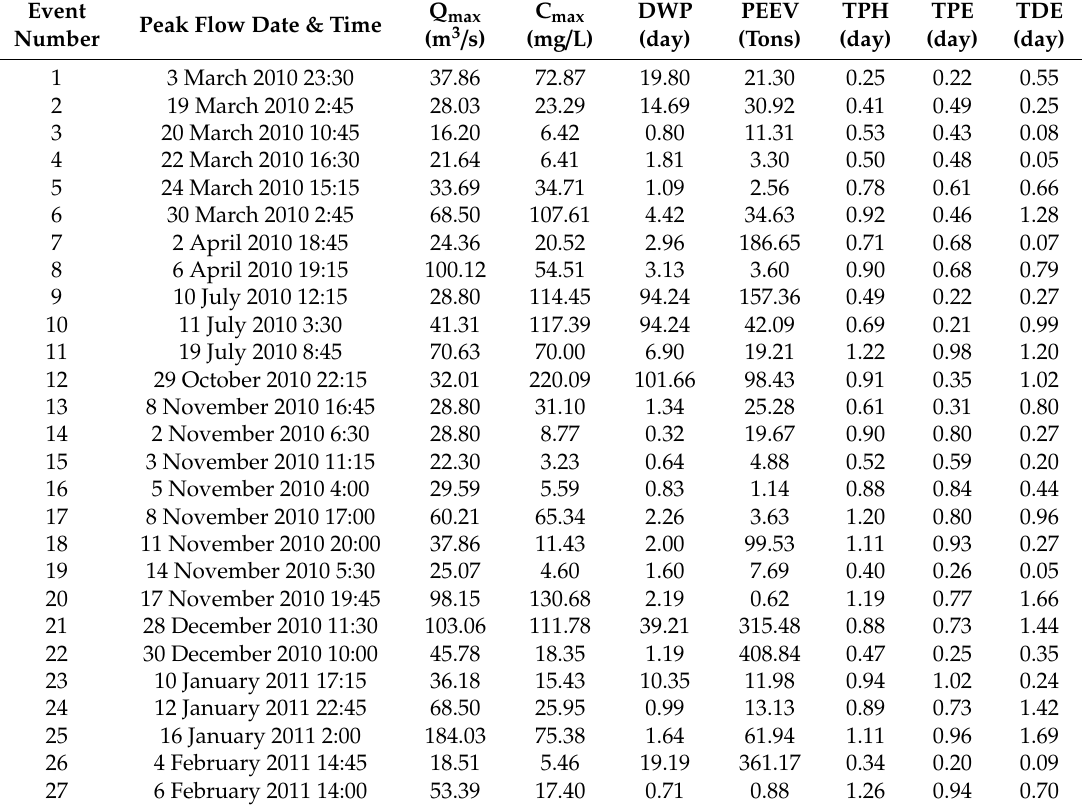
Table 2. Variables applied in the models.